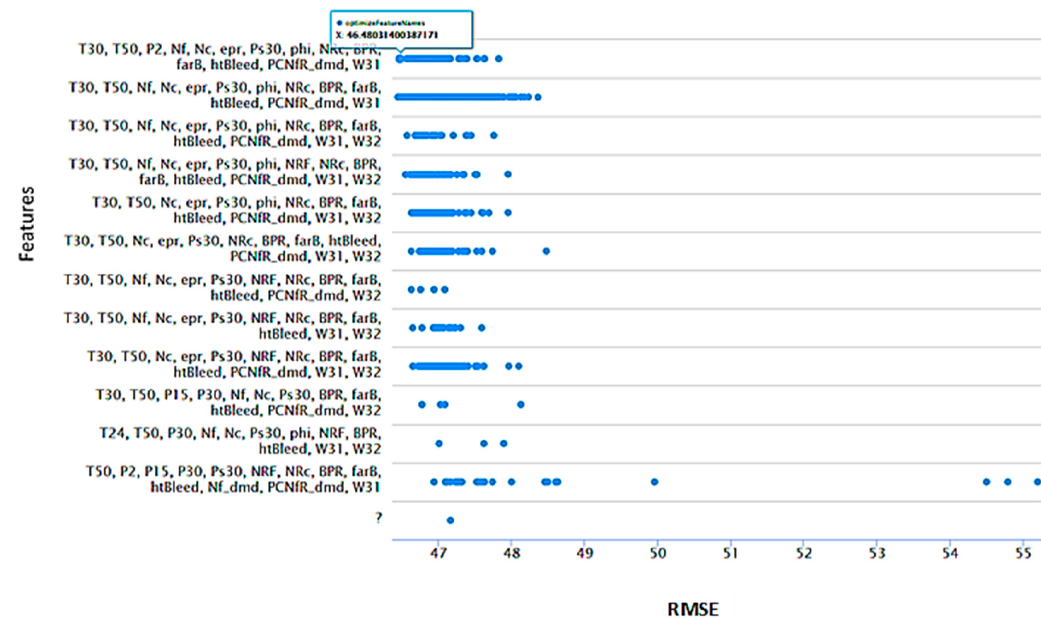
Figure 10. Validation result using Evolutionary selection.